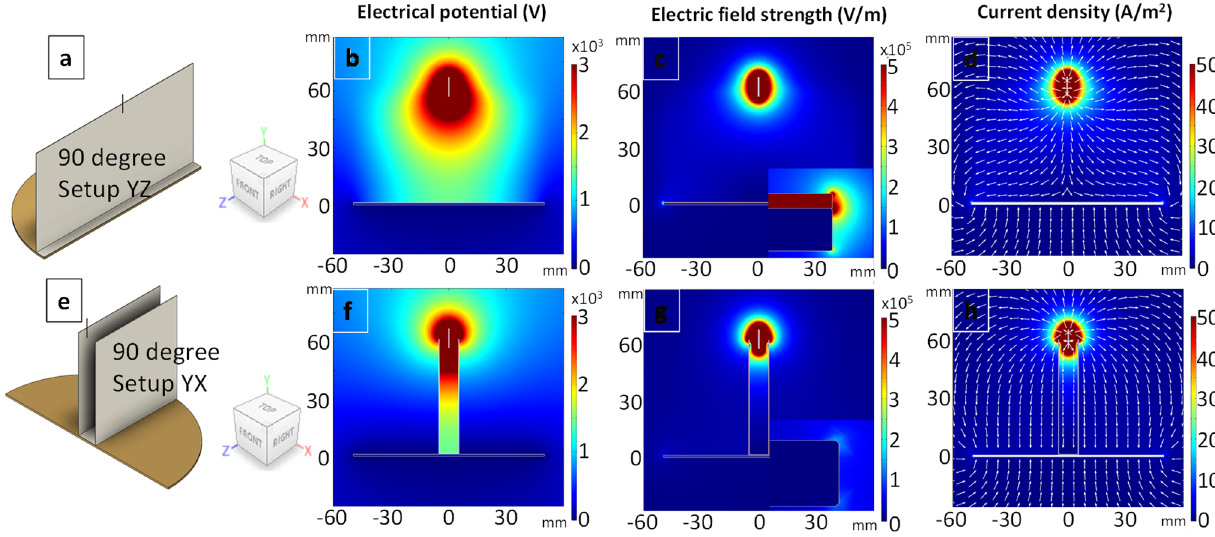
Figure 5. ( a – h ) Simulations showing the effect of changing the angle of the Vee-shield to 90°. The cross- sectional view planes are shown in ( a and e ). The simulations for the electrical potential, electric field strengths and current density in the YZ and YX planes are shown in ( b – d ) and ( f – h ) respectively. The inserts in ( c ) and ( g ) show the electric field strength at the extreme edge of the grounded collector where the red rectangle represents the